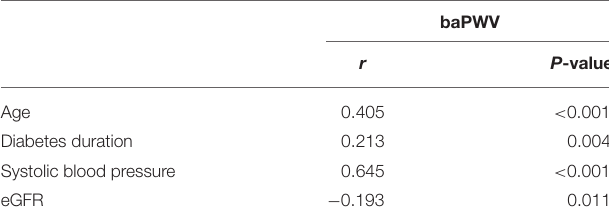
TABLE 2 | Correlation between baPWV and multiple variables at